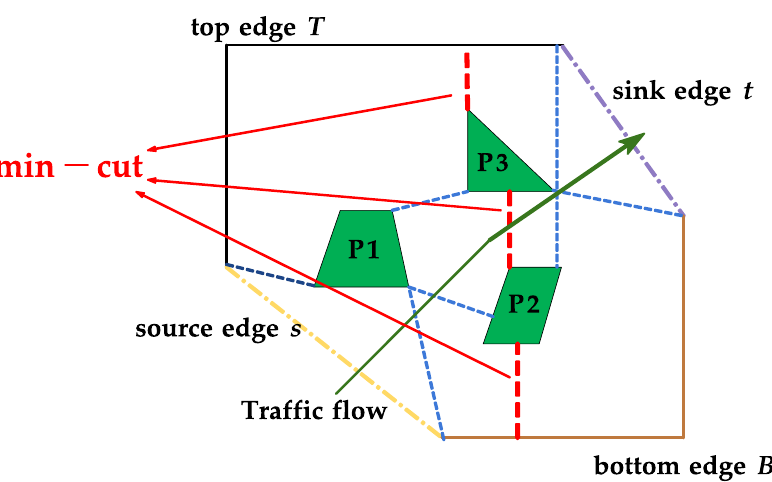
Figure 5. A shortest B – T path defines the capacity of the min-cut in the polygonal sector. Aerospace 2022 , 9 , x FOR PEER REVIEW 12 of 26